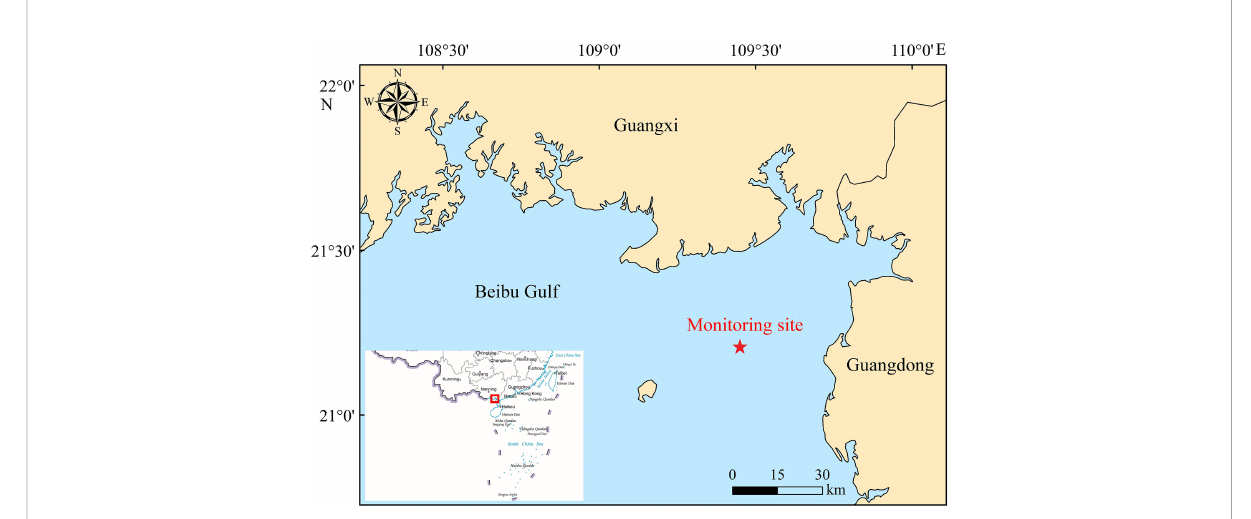
FIGURE 1 Map of the study area. The red fi ve-pointed star represents the location where sound recordings were made of Indo-Paci fi c humpback dolphins in the Beibu Gulf, South China Sea (outlined in the red box on the left-hand side of the